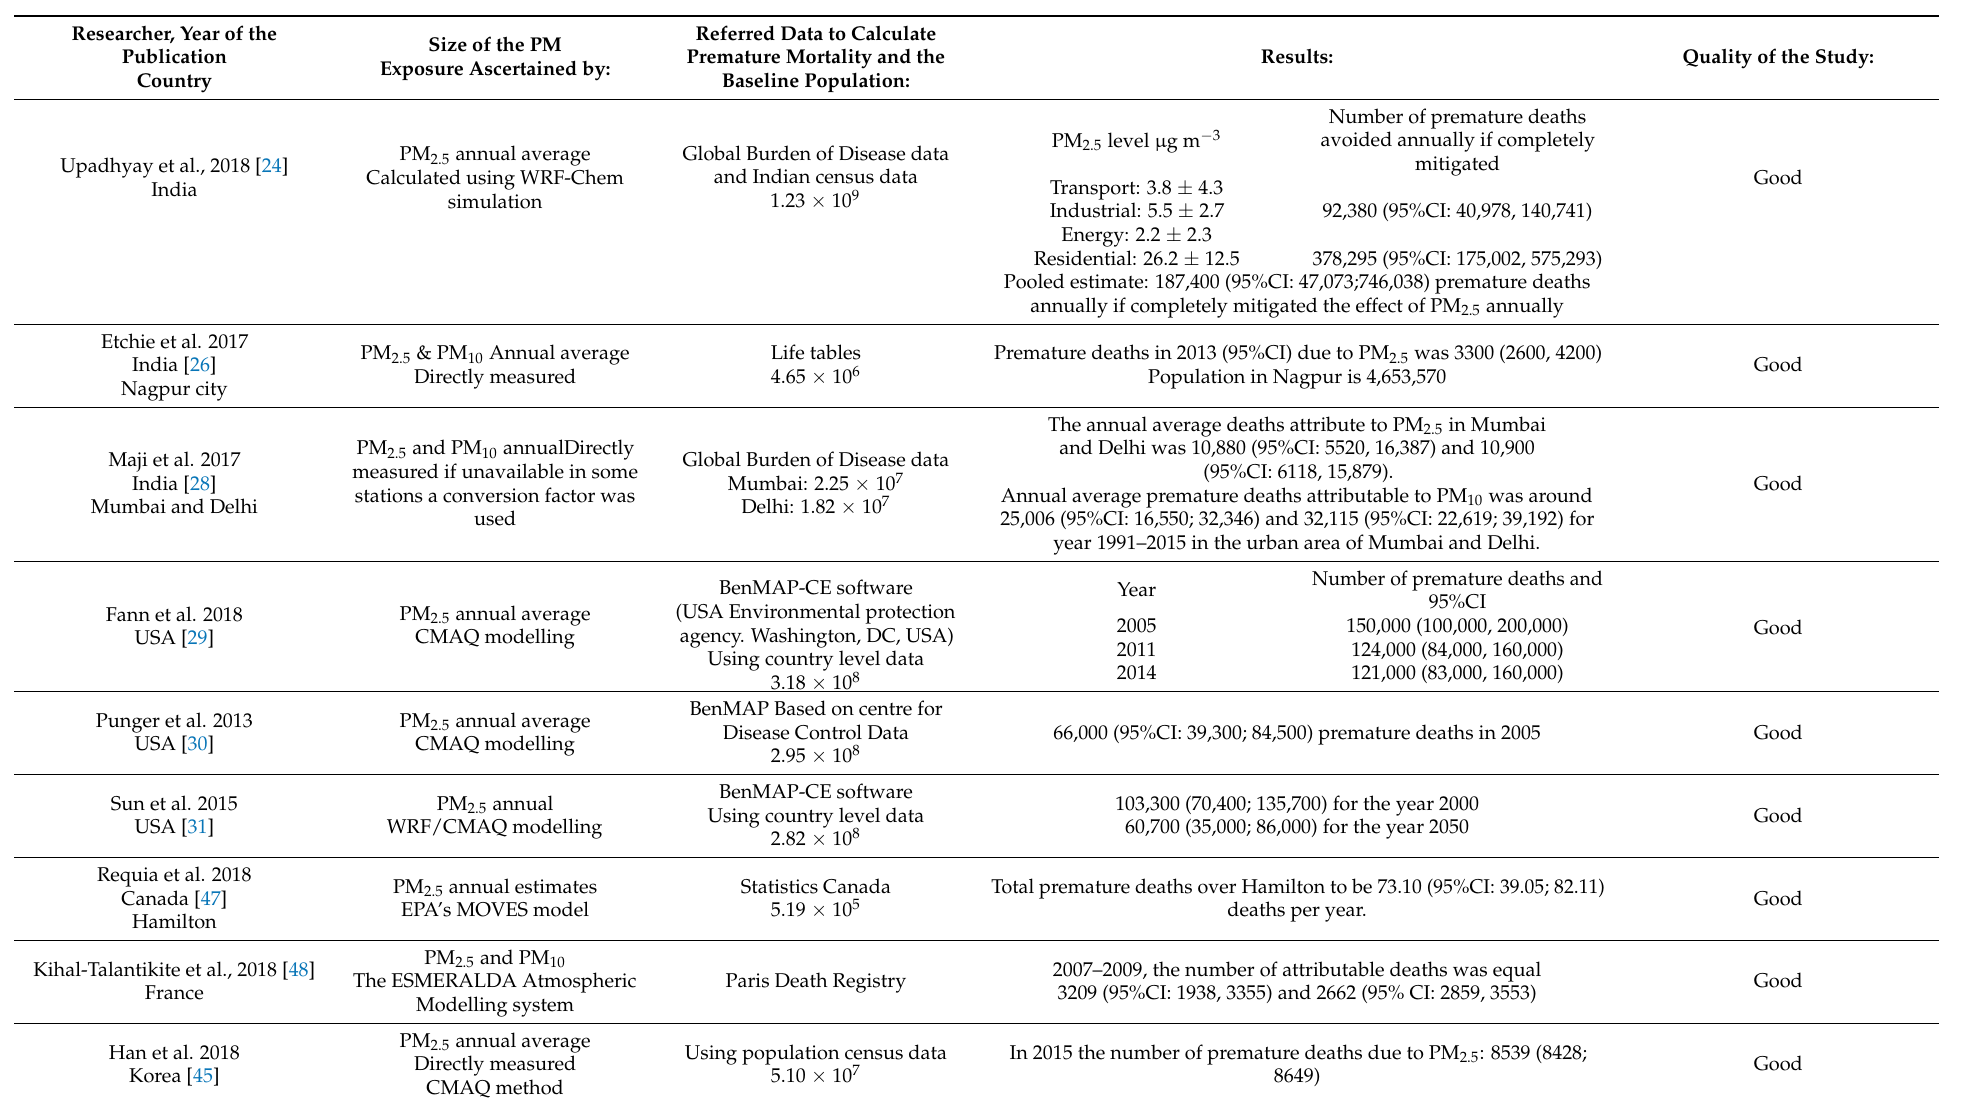
Table 2. Studies Included in the Bayesian Hierarchal